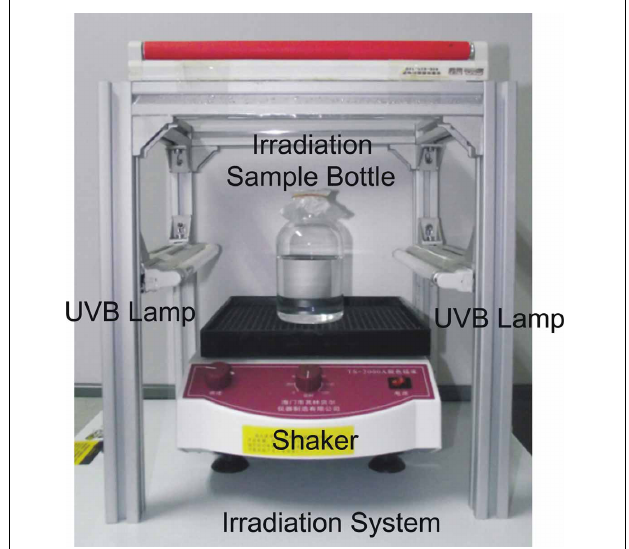
FIGURE 1 | Double-sided UV-B irradiation device. The high purity quartz irradiation bottle is designed with flat bottle well sitting on a shaker to provide a uniform irradiation